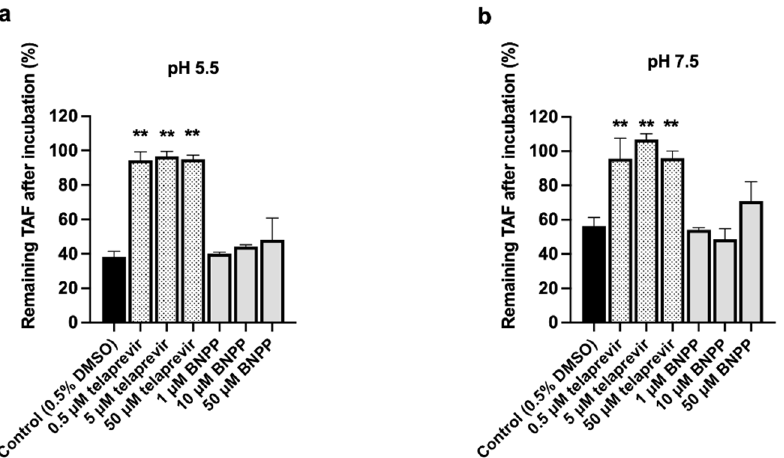
Figure 6. Effects of telaprevir and BNPP on TAF hydrolysis in HlungS9. TAF (20 μ M) was incubated with 0.5 mg/mL of HlungS9 at 37 °C for 30 min with the presence of various concentrations of telaprevir (0.5, 5, and 50 μ M) and BNPP (1, 10, and 50 μ M). Incubations were performed in MES assay buffer (pH 5.5) ( a ) and Tris buffer (pH 7.5) ( b ) to optimize the activity of native CatA and CES1, respectively. Data are shown as the remaining TAF (%) after incubations (mean ± S.D., three independent experiments). ** p < 0.01 indicates statistically significant difference compared to the control group by ANOVA test.